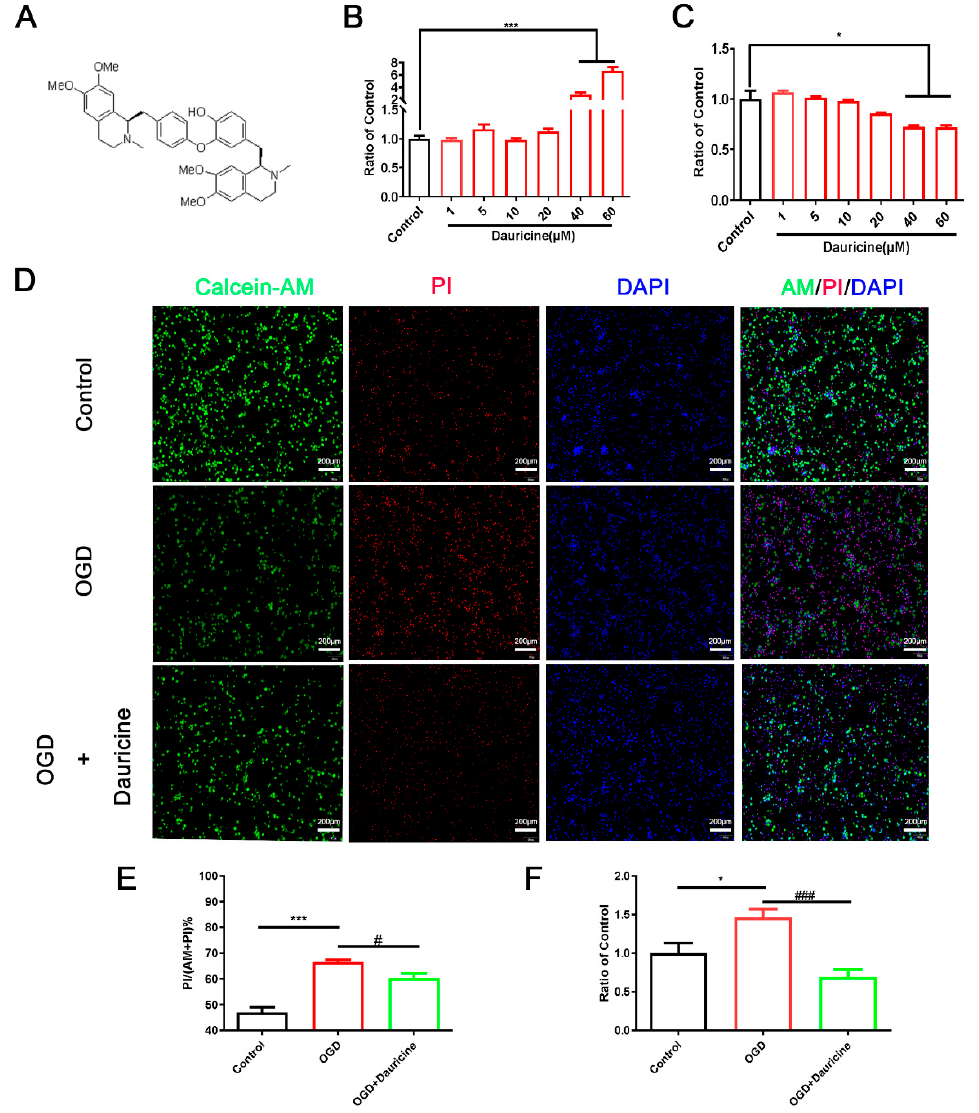
Figure 1. Dauricine decreased the primary neuron death induced by OGD-R. ( A ) The compound structure of dauricine. ( B ) LDH of primary cortical neurons cell supernatant, and ( C ) CCK8 of pri- mary cortical neurons cells were detected following dauricine (1, 5, 10, 20, 40, 60 μ M) treatment for 24 h, n = 5. Control group vs. Dauricine group, *** p < 0.001. Oxygen-glucose was applied to primary cortical neuron cells for 15 min; then, they were reperfused and treated with dauricine (1 μ M) for 3 h. ( F ) The viability of primary cortical neuron cells was detected by LDH, and cell viability was also showed by calcein-AM and PI buffer ( D ) and quantified ( E ), n = 5. Control group vs. OGD group, * p < 0.05, *** p < 0.001, OGD group vs. (OGD + Dauricine) group # p < 0.05, ### p < 0.001, unpaired Student’s t -test. 3.2. Dauricine Decreased Brain Infarct Size and Neurological Deficits after tMCAO Injury We verified whether the administration of dauricine has the same neuroprotective in vivo as in vitro. An infarction of the right hemisphere was developed after 1 h of MCAO, followed by reperfusion after 1 day, 3 days, and 7 days, and the mouse studies were con- ducted through behavior experiments (Figures 2A). From the cerebral blood flow after MCAO, it was seen that the blood flow of the infarct side brain significantly dropped, showing the success of model (Figures 2B). The TTC staining method was used to evaluate the cerebral infarct volume. Compared to the vehicle-treated group, the administration of dauricine showed a 56% reduction in infarct volume at 7 day after MCAO (Figure 2C,D;